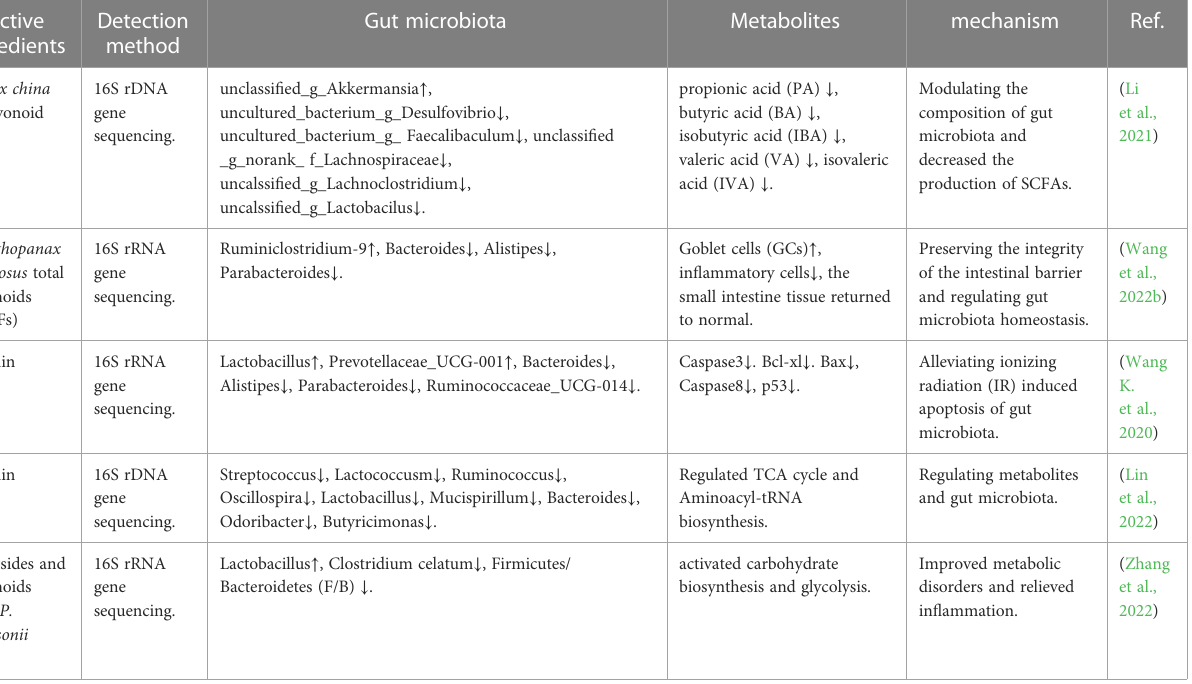
TABLE 3 The fl avonoids from TCM regulated gut